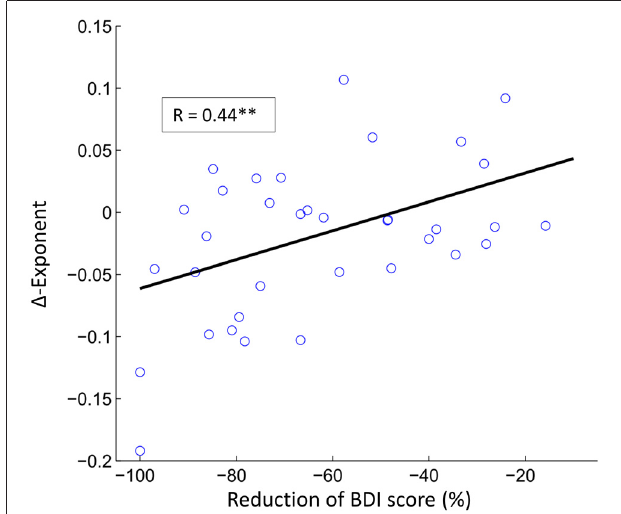
FIGURE 5 | The reduction in depression symptoms correlate with reductions in LRTC in theta oscillations. The scatter plot shows the relationship between reduction of BDI score and the reduction of theta LRTC in the mindfulness treatment group (Pearson correlation coefficient, r = 0.44, ∗∗ p < 0.01) at electrode